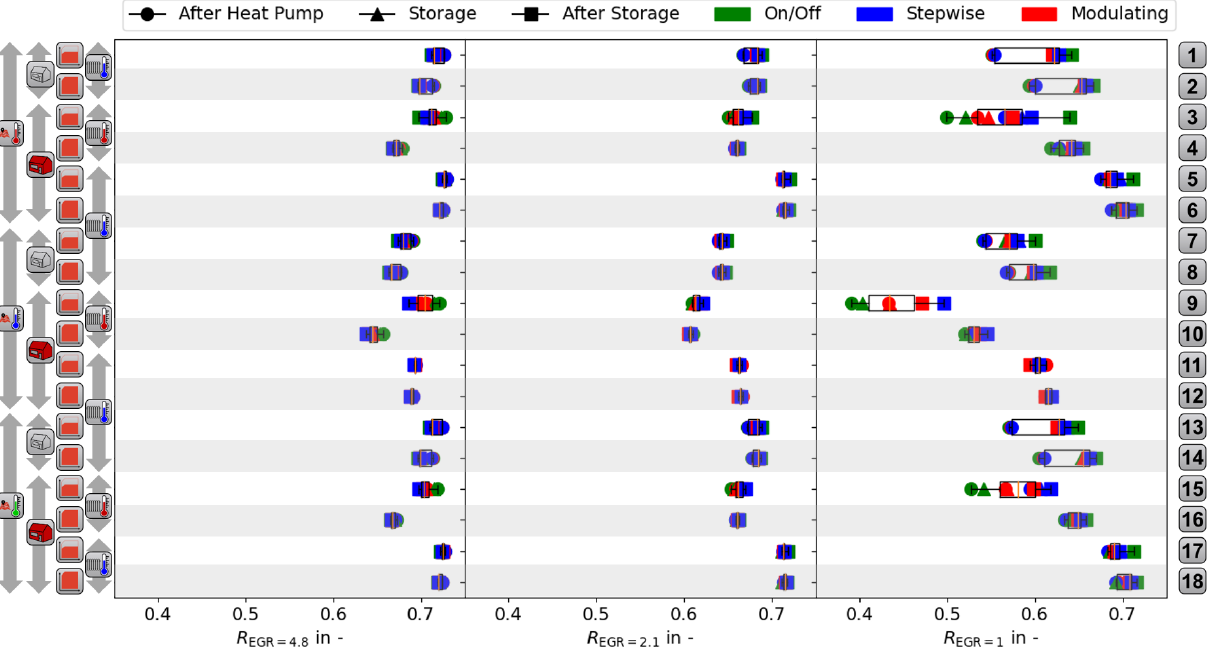
Figure A2. Boxplots for all conducted studies regarding costs and emissions reduction R for differ- ent